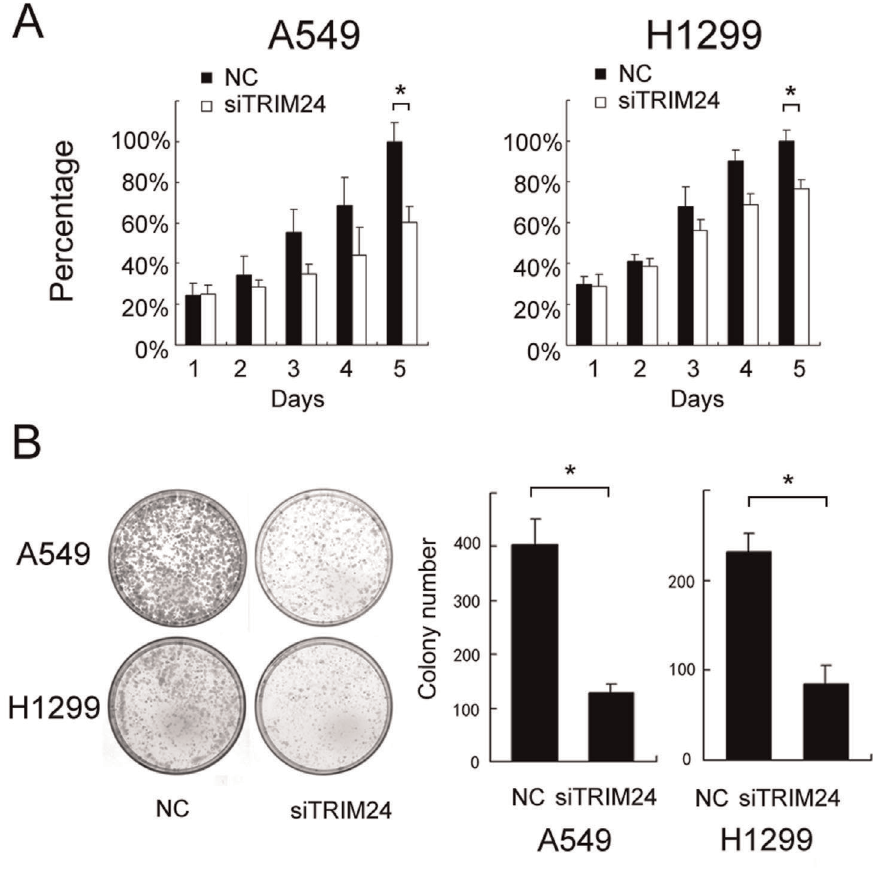
Figure 4. TRIM24 depletion impaired cancer cell proliferation. A. MTT assay was performed after TRIM24 siRNA treatment. A reduction of absorbance was observed (p , 0.05 at day 5 for both A549 and H1299). B. Assessment of clonogenic potentials of the TRIM24-depleted cancer cells. Numbers of colonies were counted. The number of colonies formed by cells treated with TRIM24 siRNA was far less than that of control cells (p , 0.05). Columns, mean; bars, SD. *p ,